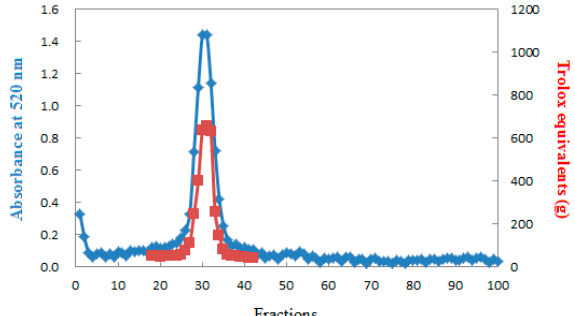
Figure 7. Gel filtration chromatography purification profile for S. chinensis anthocyanins after macroporous resin chromatography.